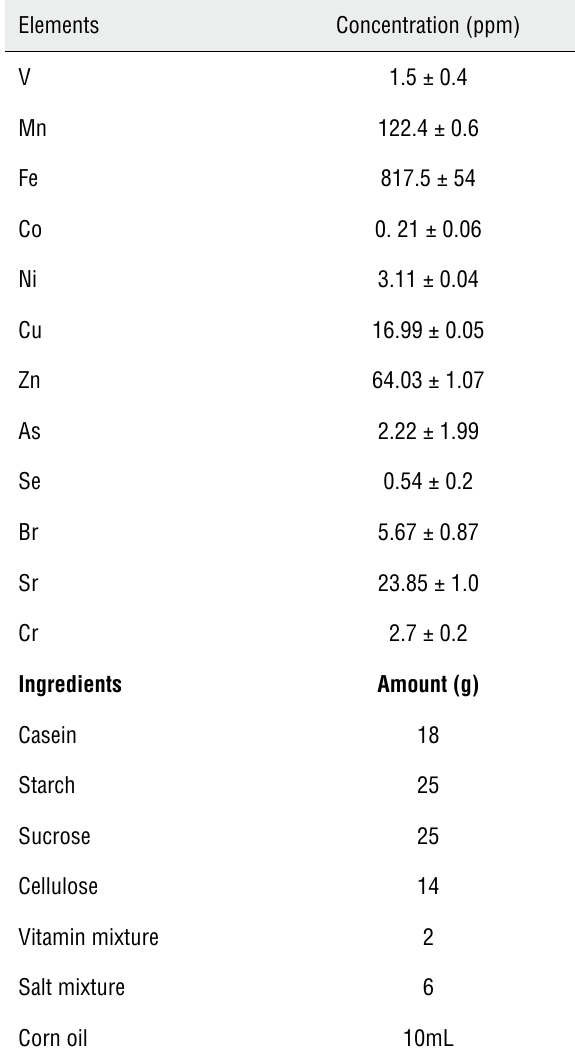
Table 1 - Composition of standard animal